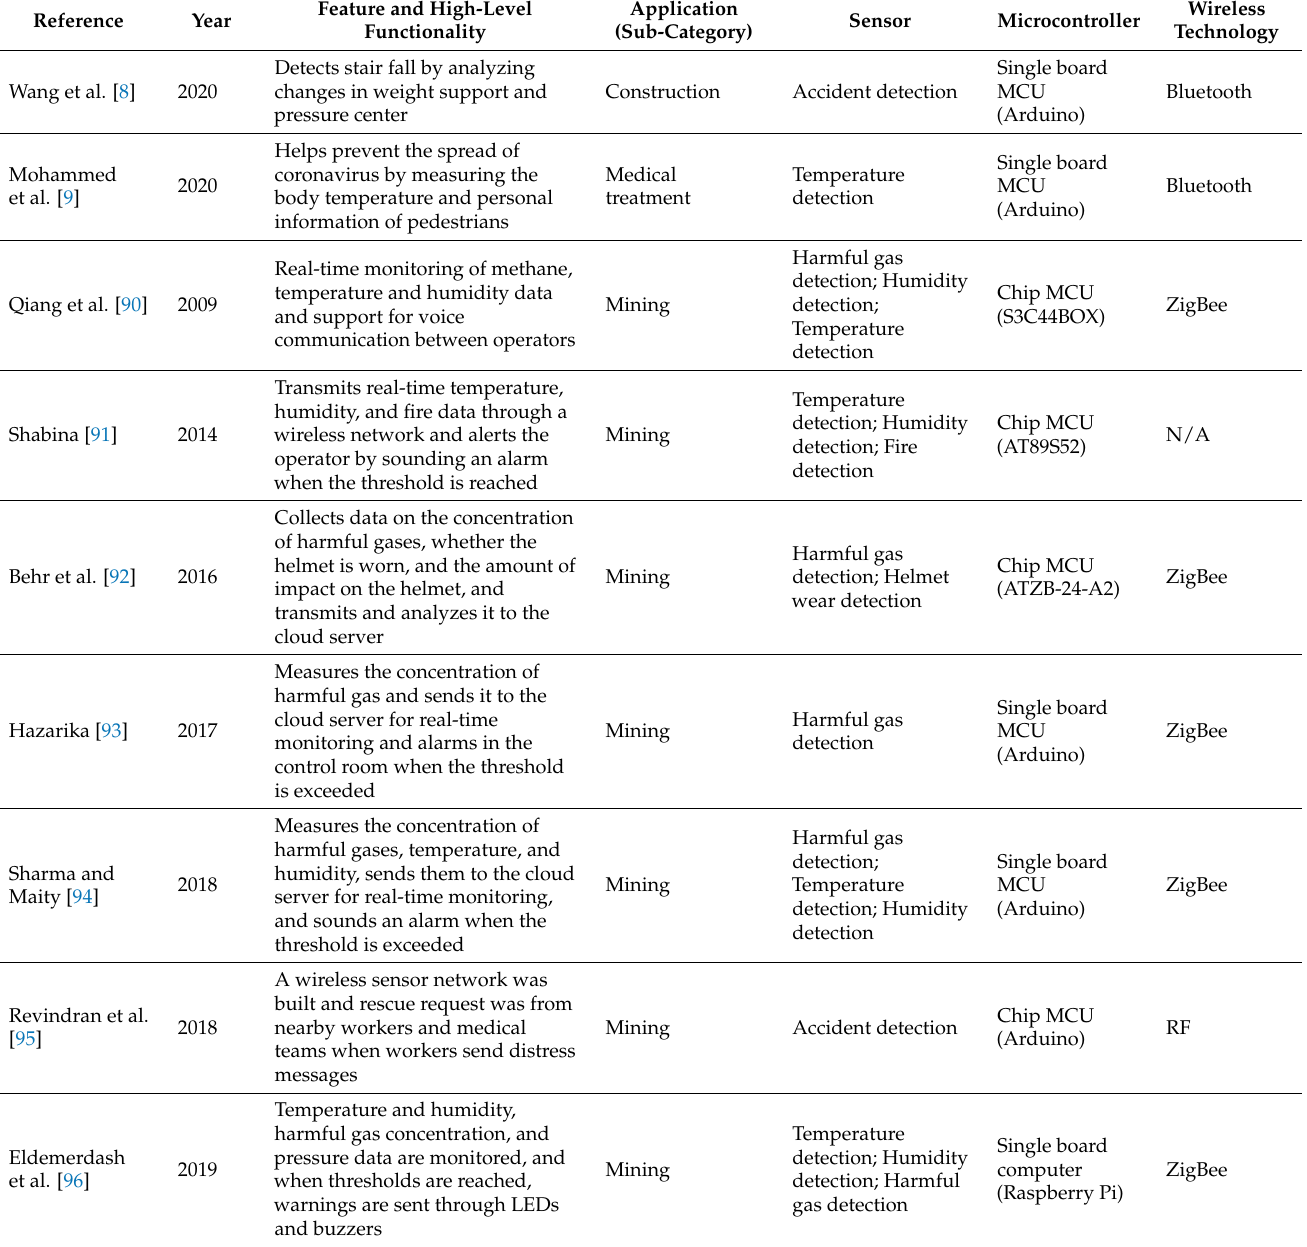
Table 3. The application fields include mining, construction, petrochemistry, disaster pre- vention, and medical treatment. Figure 6 shows the percentage of smart helmet studies conducted in each application field. Table 3. Summary of smart helmet applications for workers in the fields of mining, construction, petrochemistry, disaster prevention, medical treatment,